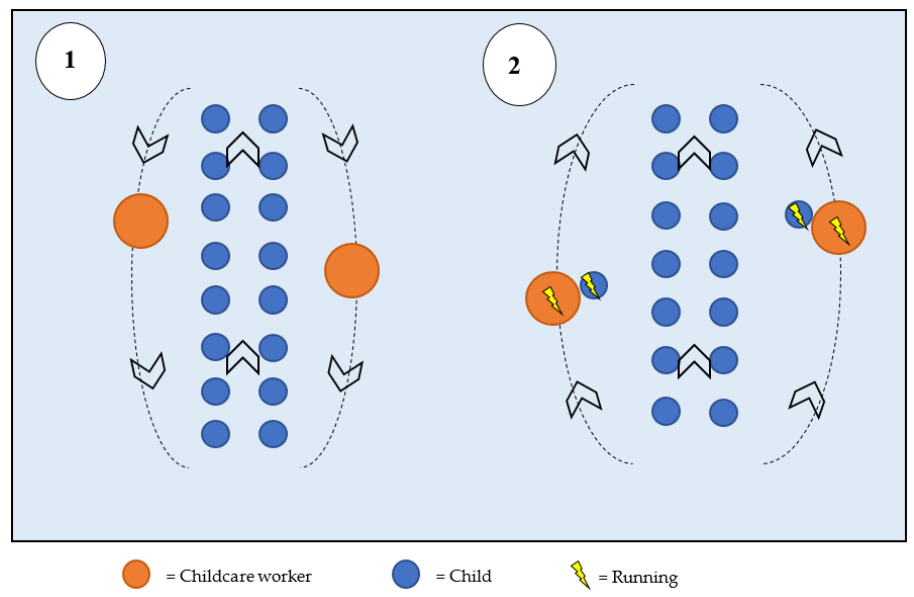
Figure 3. The Goldilocks Train. Further details in the text. Figure A3. The Goldilocks Train. Further details in the text.